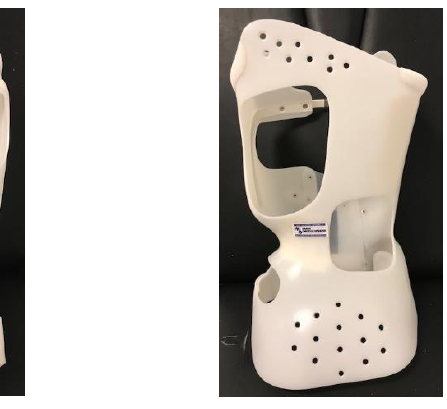
Figure 1. Cheneau – Toulouse – Munster Brace